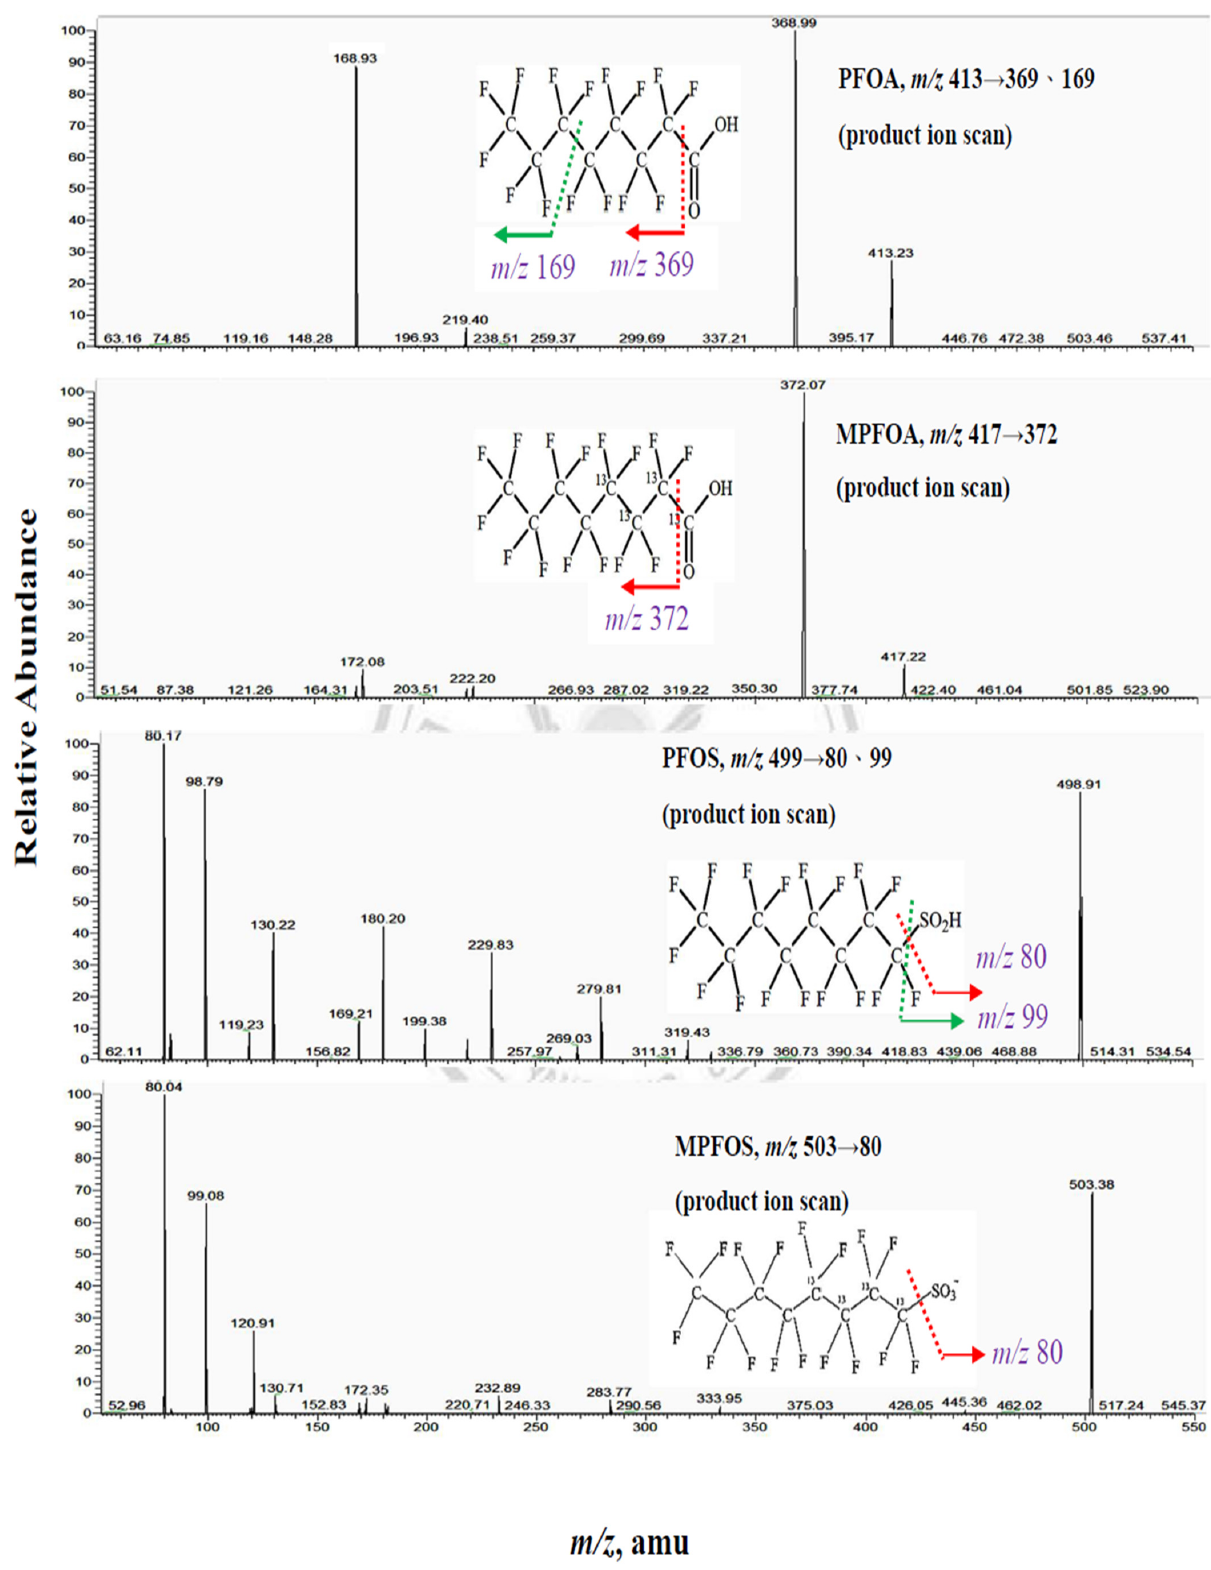
Figure A2. The product ion scans of PFOA and PFOS.